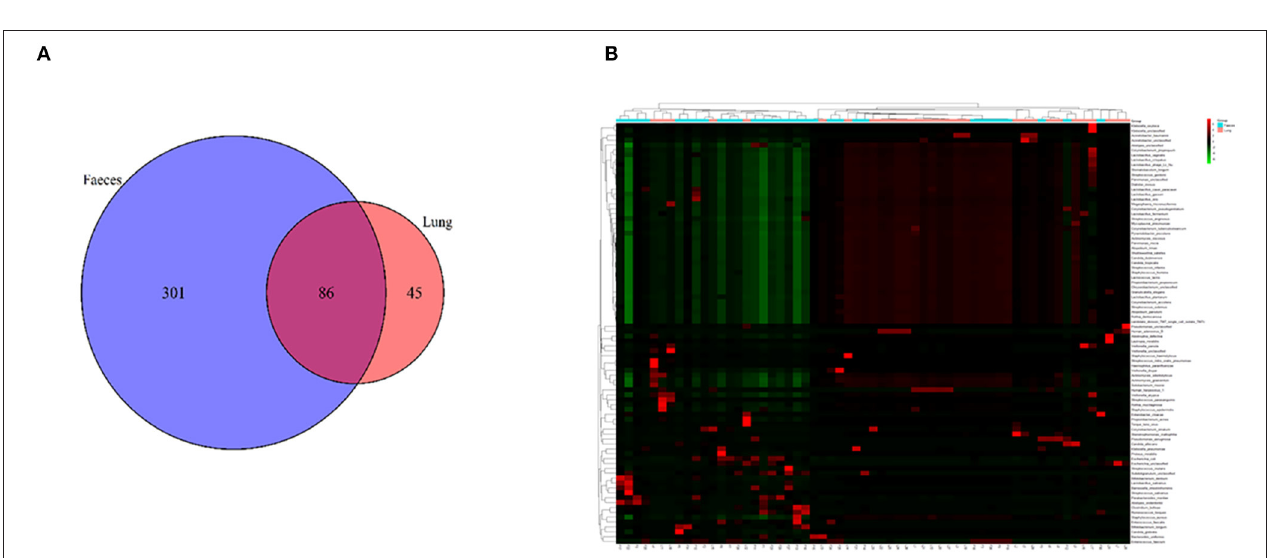
FIGURE 2 | (A) A Venn diagram of the microbiome of the lung and gut. (B) Cluster analysis of the microbiome in the lung and gut. F, feces; L, lung.